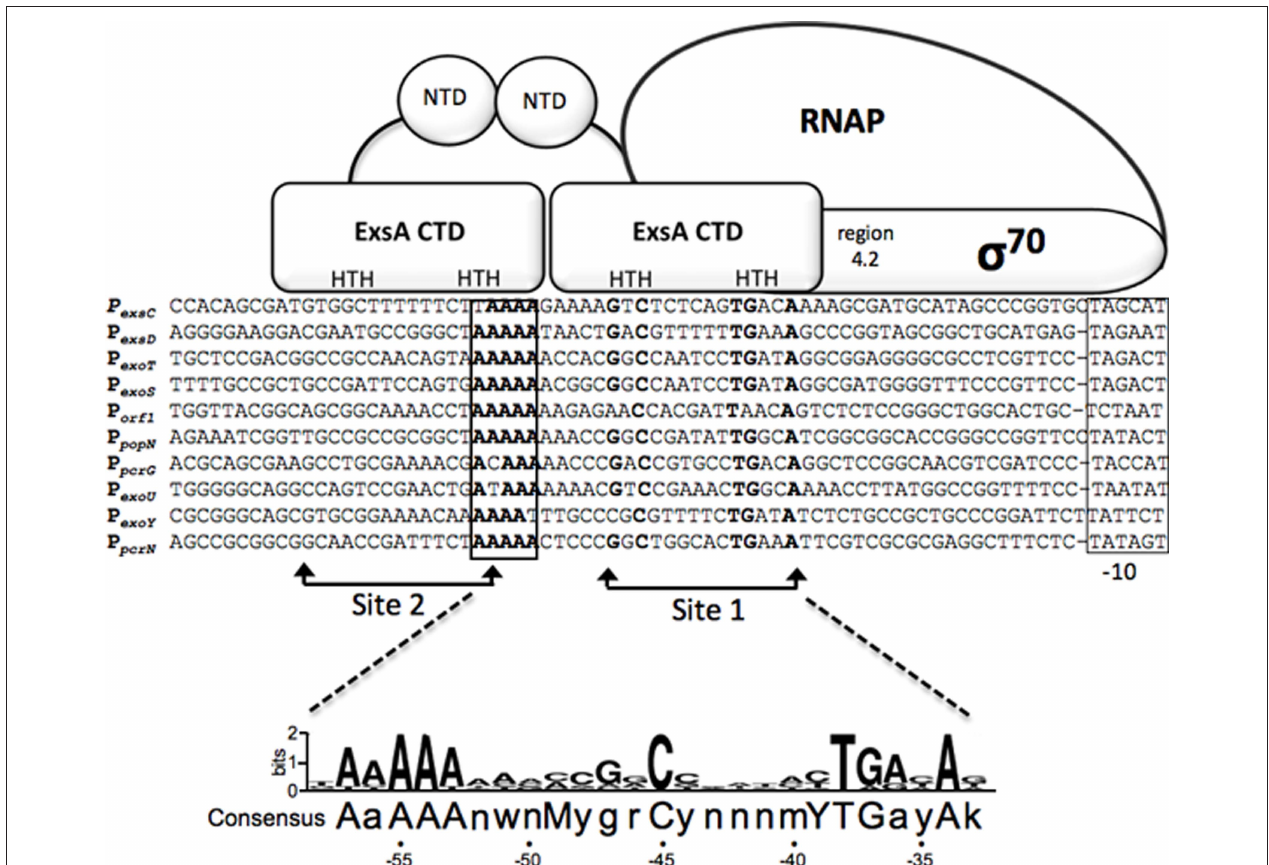
FIguRE 1 | Sequence alignment of ExsA-dependent promoters and working model for promoter recognition and recruitment of σ 70 -RNAP by ExsA. Nucleotides in bold are highly conserved in all ExsA-dependent promoters and have been shown through mutagenesis and DNA-biding studies to be important for ExsA-dependent activation. The boxed sequences represent the